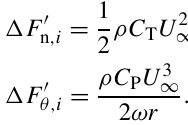
Table 3. Example of the calibration table to obtain the relations between the local velocity on the node ( U d ,i ) and the unperturbed velocity ( U ∞ ) used for the local force calculation on the